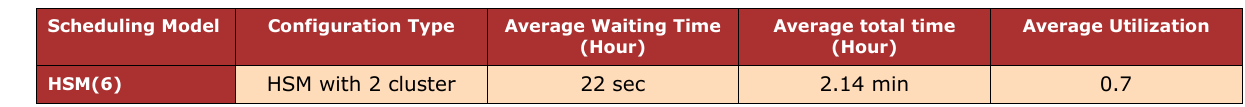
Table 19. Properties of final configuration for settings with medium interaction level.